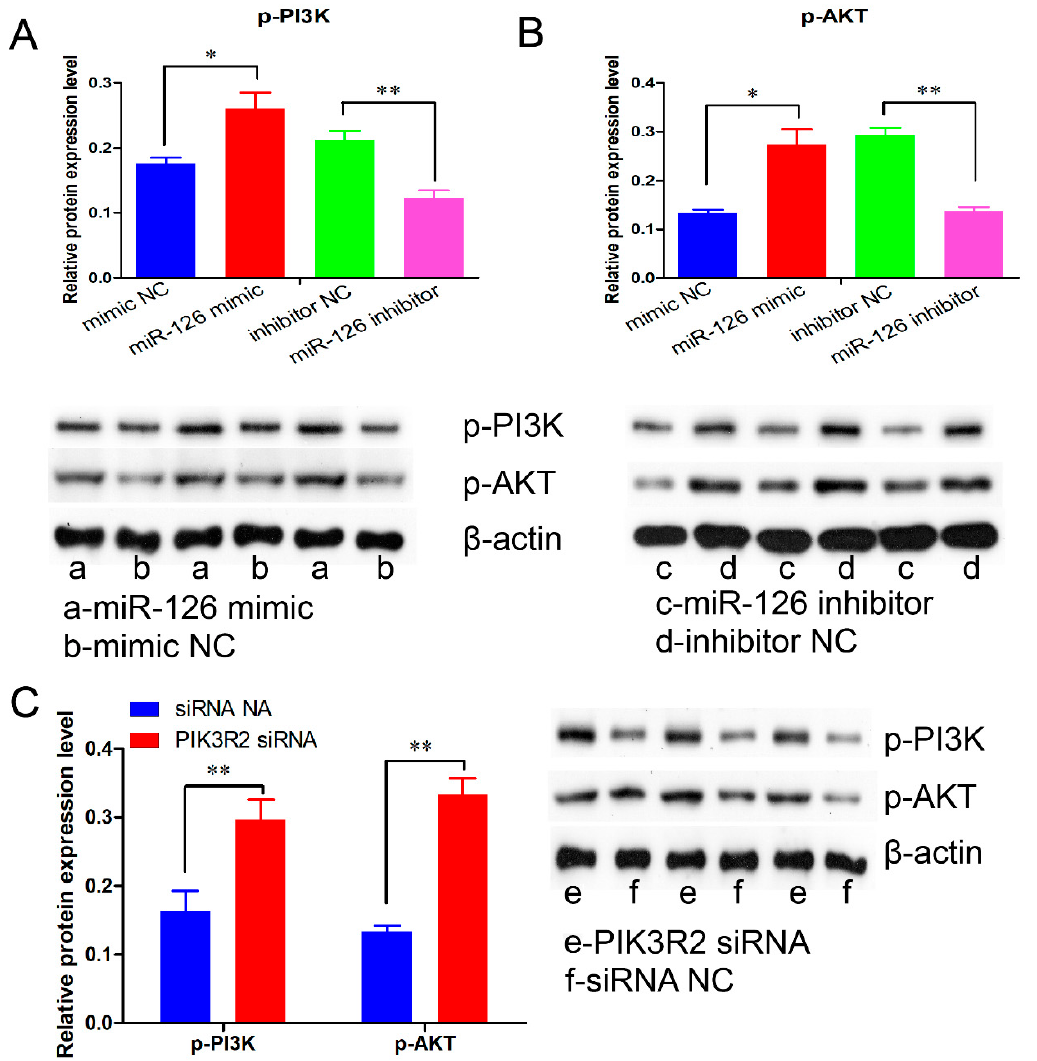
Figure 7. miR-126 activates the PI3K/AKT signaling pathway. The p-PI3K (phospho Tyr458) and p-AKT (phospho Ser473) protein levels were detected using a Western blot assay ( n = 3). The β -actin gene was used as an internal control. ( A , B ) The effects of miR-126 mimic and miR-126 inhibitor on the p-PI3K ( A ) and p-AKT ( A ) protein levels. ( C ) The p-PI3K and p-AKT protein levels were elevated by the PIK3R2 inhibition. Data are presented as the mean ± SEM, * p < 0.05 and ** p <